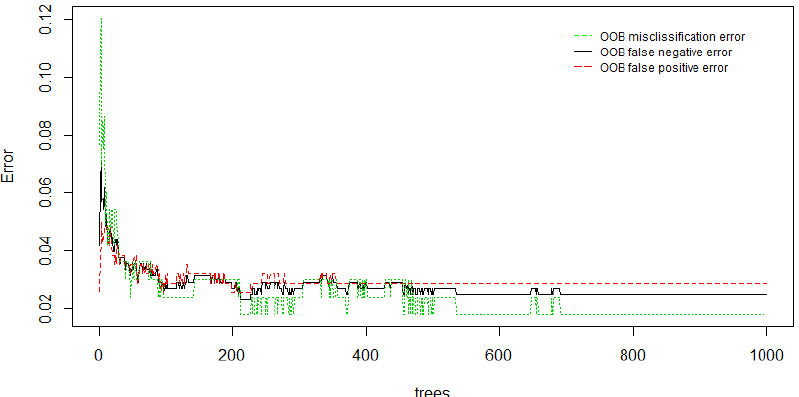
Figure 20. Selecting the tree size for the breast cancer data.